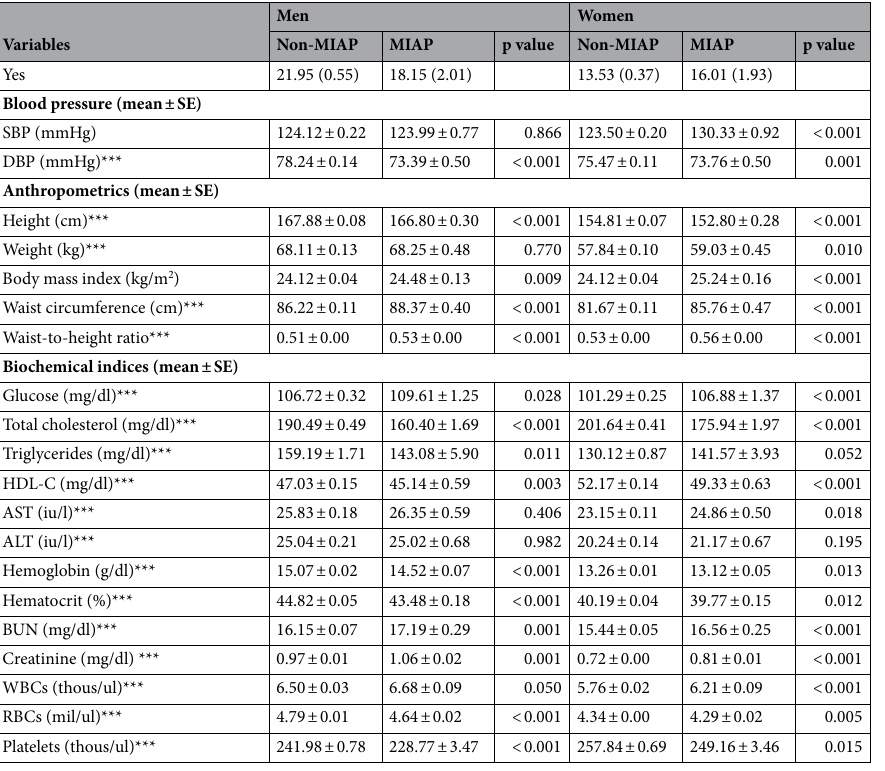
Table 1. Demographic characteristics of the subjects. MIAP myocardial infarction or angina pectoris, IHD ischemic heart disease, SBP systolic blood pressure, DBP diastolic blood pressure, HDL-C high-density lipoprotein cholesterol, AST aspartate aminotransferase, ALT alanine aminotransferase, BUN blood urea nitrogen, WBC white blood cell, RBC red blood cell. *p < 0.05, **p < 0.01, ***p < 0.001. *, ** and *** indicate p values for sex differences between all men and women. Continuous data are represented as the mean ± SE (standard error). Categorical data are represented as percentages (SEs). p values were obtained from Rao-Scott chi-squared tests for categorical variables and from a general linear model for continuous variables between the group without MIAP and the group with